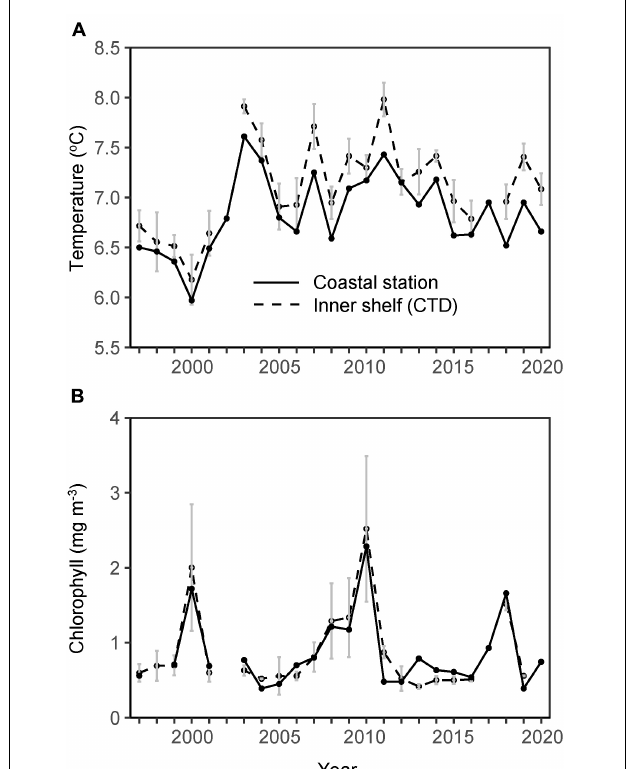
FIGURE 3 | (A) Temperature and (B) chlorophyll from CTD casts, averaged vertically over 6–50 m and laterally over the inner shelf (dashed black lines, domain defined by the 100 m depth contour) and from coastal stations O and S, respectively (solid black lines) in late April 1997–2020 (Jacobsen et al., 2018, updated). Vertical lines show spatial standard deviation for the CTD